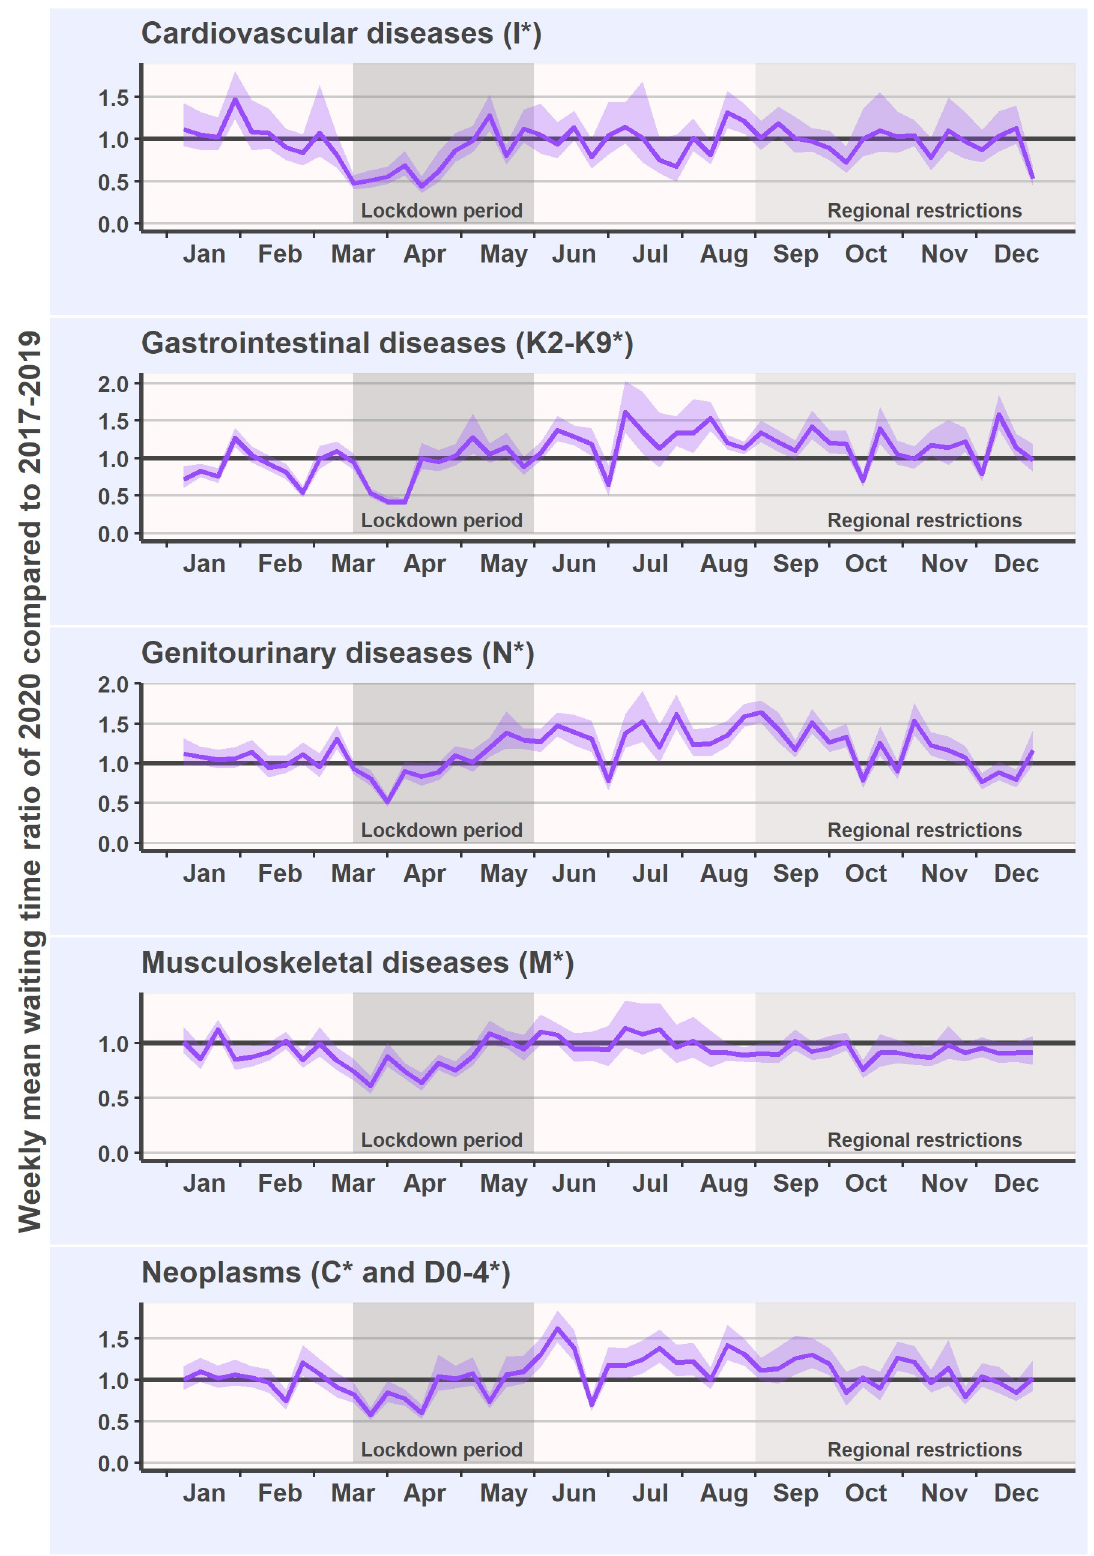
Fig 3. Ratio between the weekly mean waiting time and 95% confidence intervals in 2020 (purple line) and the mean waiting time in the reference years (black parallel line) in elective surgeries of the most common diagnosis groups.